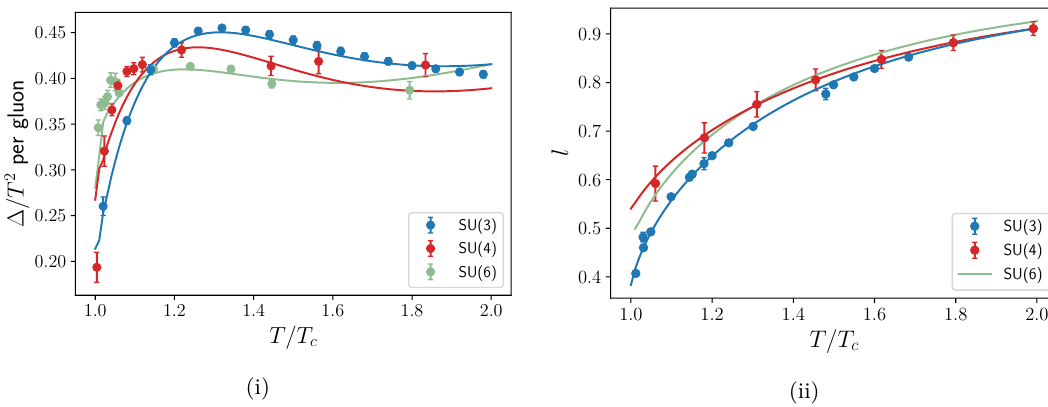
Figure 2. Best-fit to lattice data for the interaction measure (i) and Polyakov loop (ii) obtained from the model with a nonperturbative potential given in eq. (3.7) for N = 3 , 4 and 6